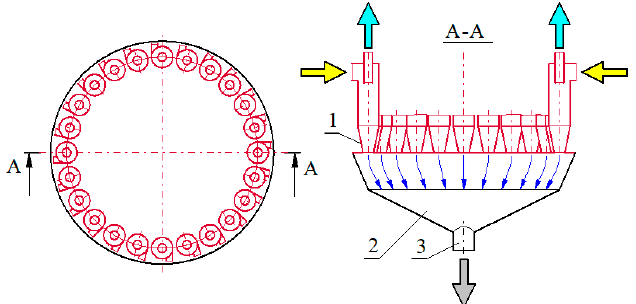
Figure 6. Diagram of the sedimentation basin maintaining position symmetry of all cyclones in relation to the suction stub: 1—cyclone, 2—sedimentation basin, 3—suction pipe stub.